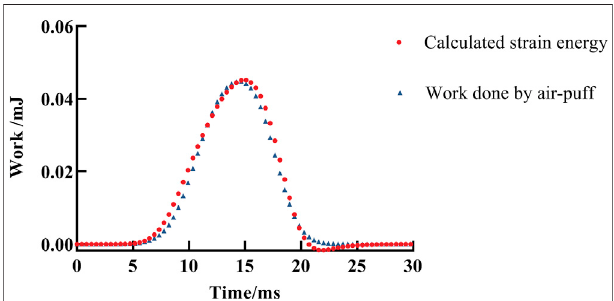
FIGURE 7 | A fi tting result of work done by air-puff force attaining the whole corneal displacement during the Corvis ST test by the visco- hyperelastic model. The red solid dot is the fi tting result, and the blue triangle representsthecalculatedworkdone byair-puffforce attaining thewhole corneal displacement during the Corvis ST